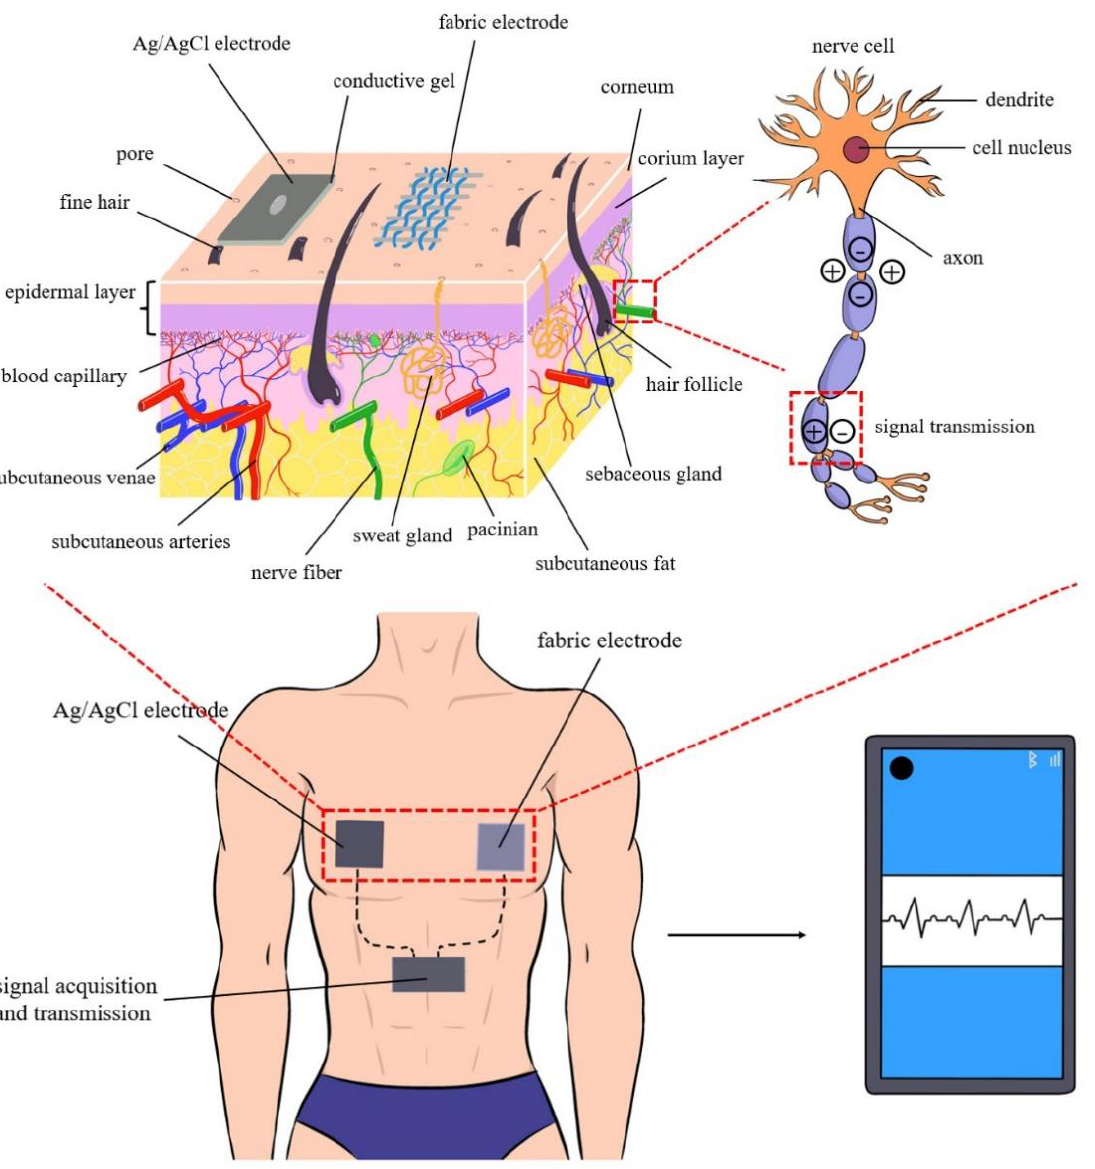
Figure 1. The potential change generated when the heartbeats are transmitted to the skin surface through the nerve, and the electrode is attached to the skin surface to collect the potential change signal, which is transmitted to the electronic equipment through the signal transmission equipment (wire or Bluetooth, etc.).